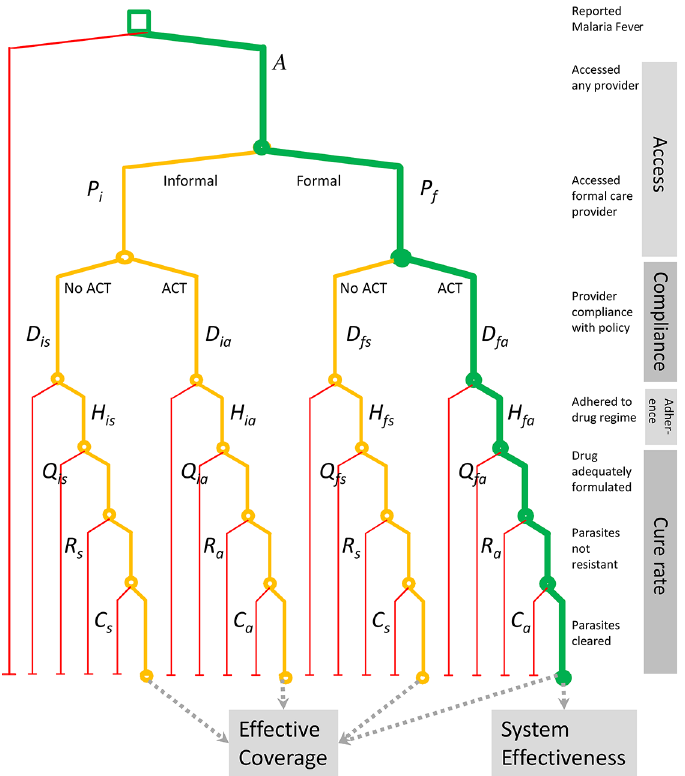
Fig 1. Decision Tree Model for Case Management of Uncomplicated